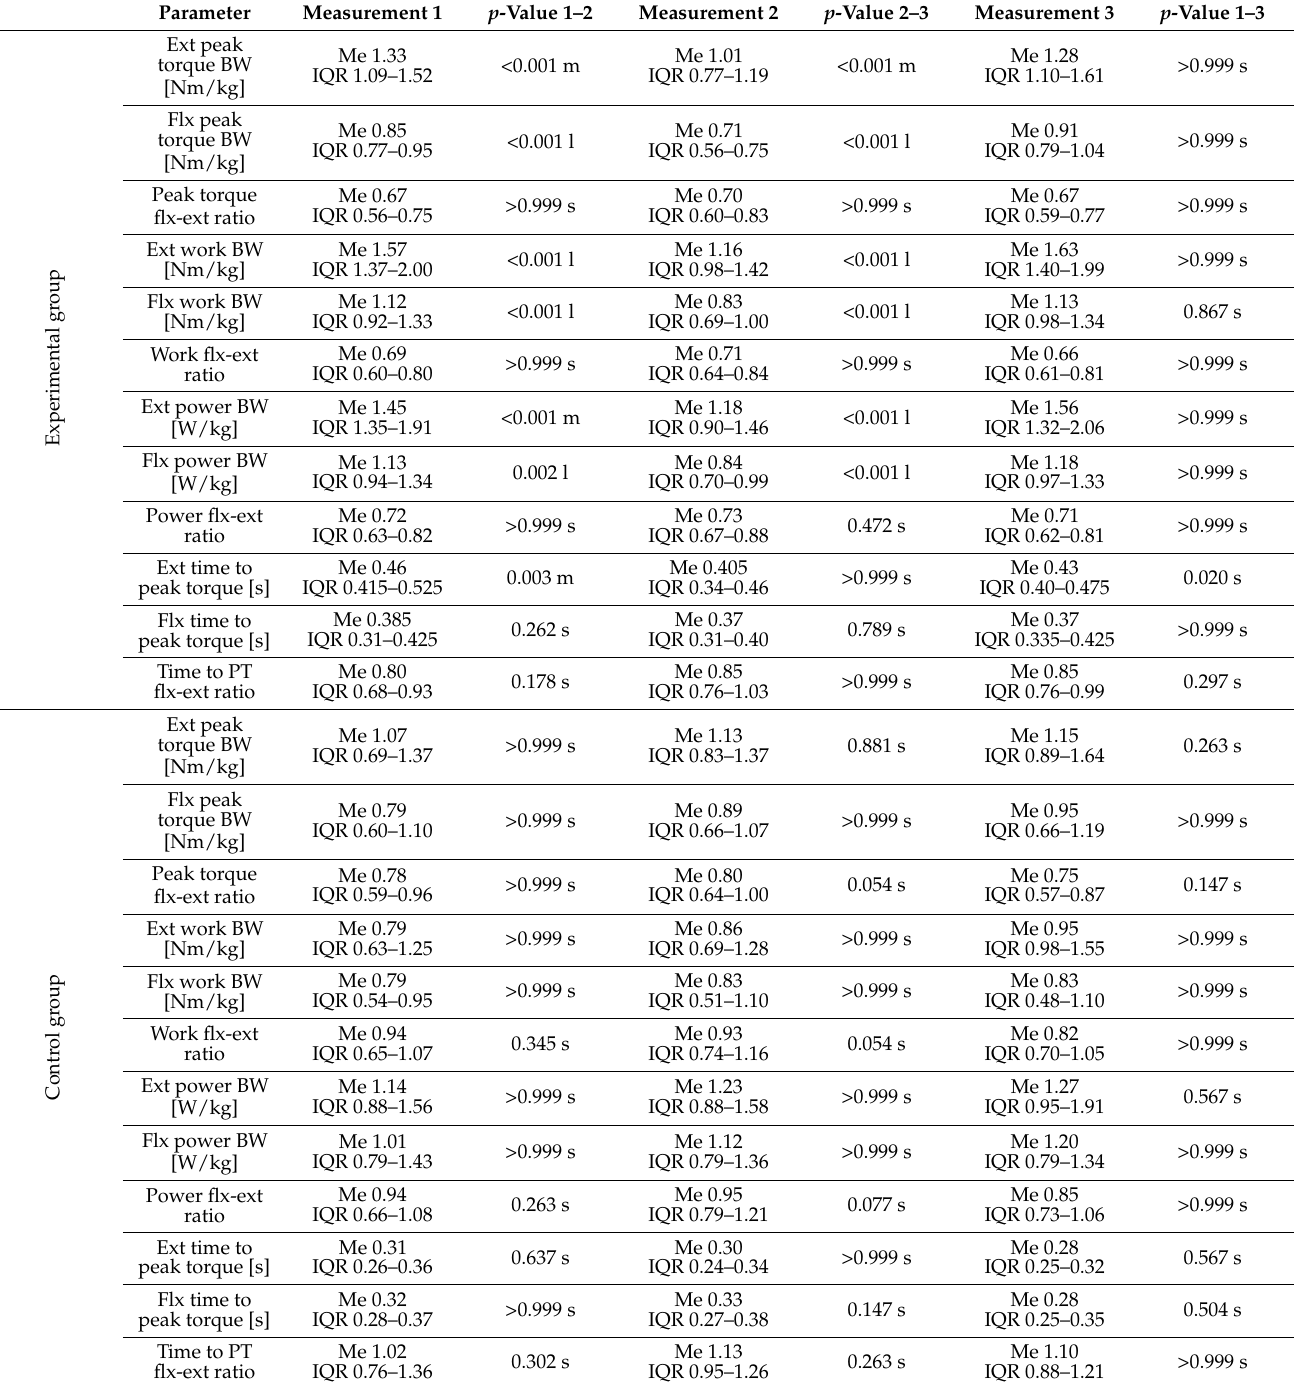
Table A2. Results of the measurement in the 120 ◦ /s test for the experimental and the control group, where: s—means small, m—medium and l—large effect size calculated by Cohen’s